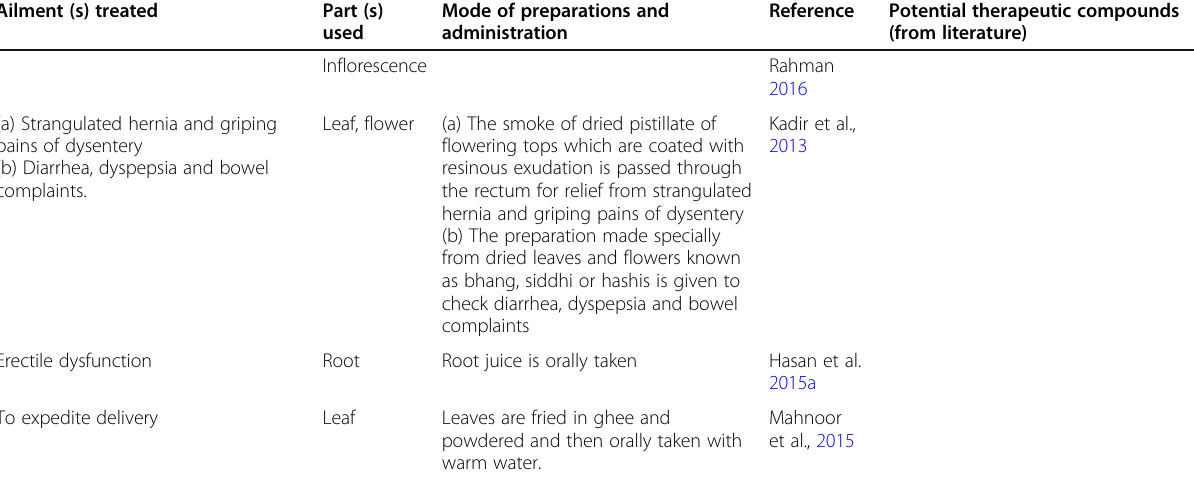
Table 2 List of traditional uses of Cannabis sativa as phytomedicine used by the folk medicine practitioners of Bangladesh and potential therapeutic compounds